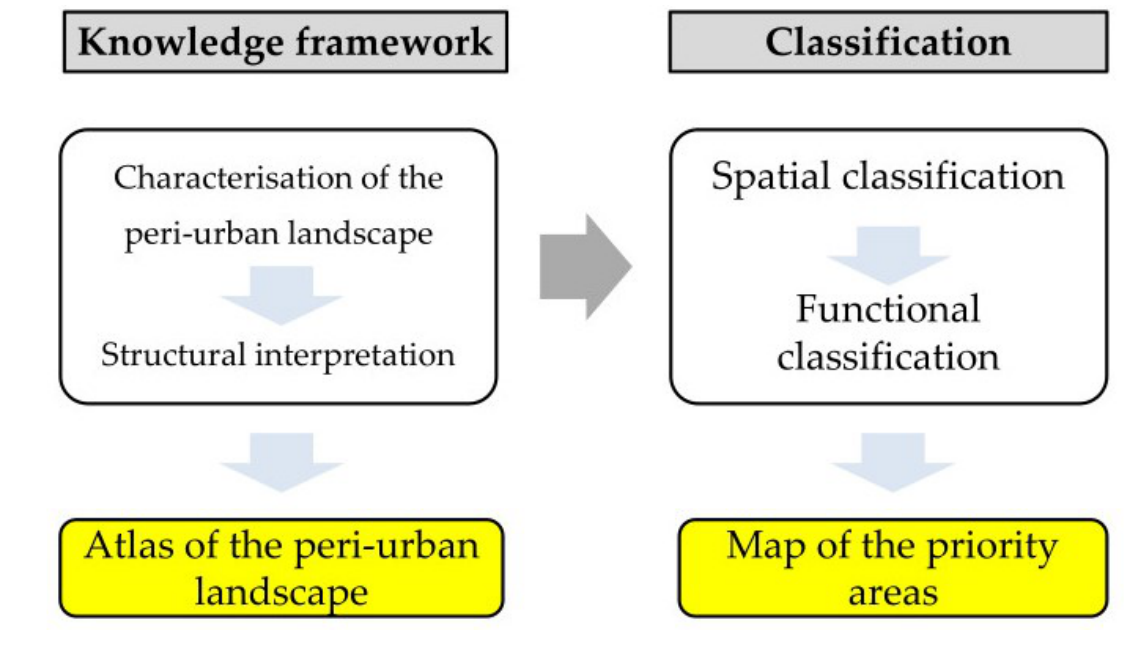
Figure 2. Map of the Turin peri-urban area (TPA).